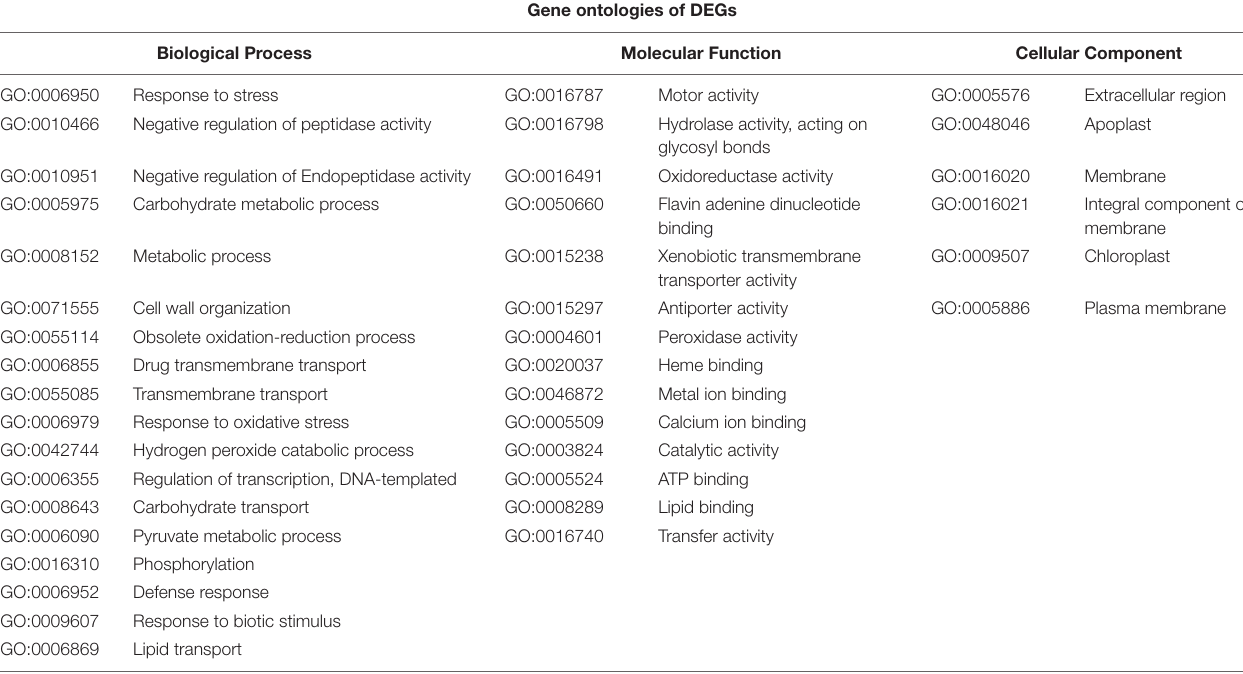
TABLE 3 | The gene ontologies of mutually differentially expressed genes (DEGs) of homo-grafted watermelon (WW) and homo-grafted squash (SS). Gene ontologies of DEGs Biological Process Molecular Function Cellular